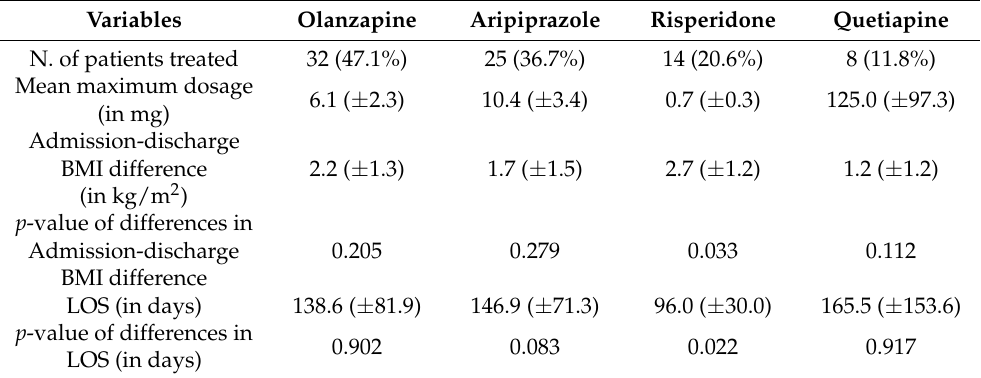
Table 3. Treatments with different AAPs in the whole sample. Continuous variables expressed as mean ( ±